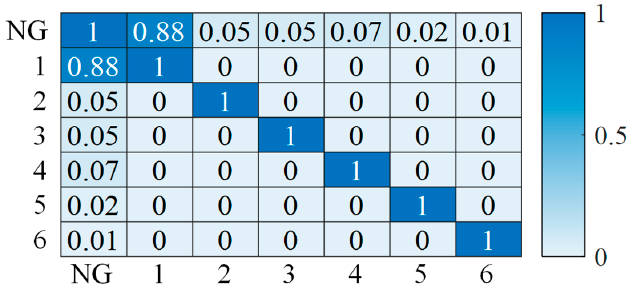
Figure 10. The principal components obtained by PCA (Athens case).